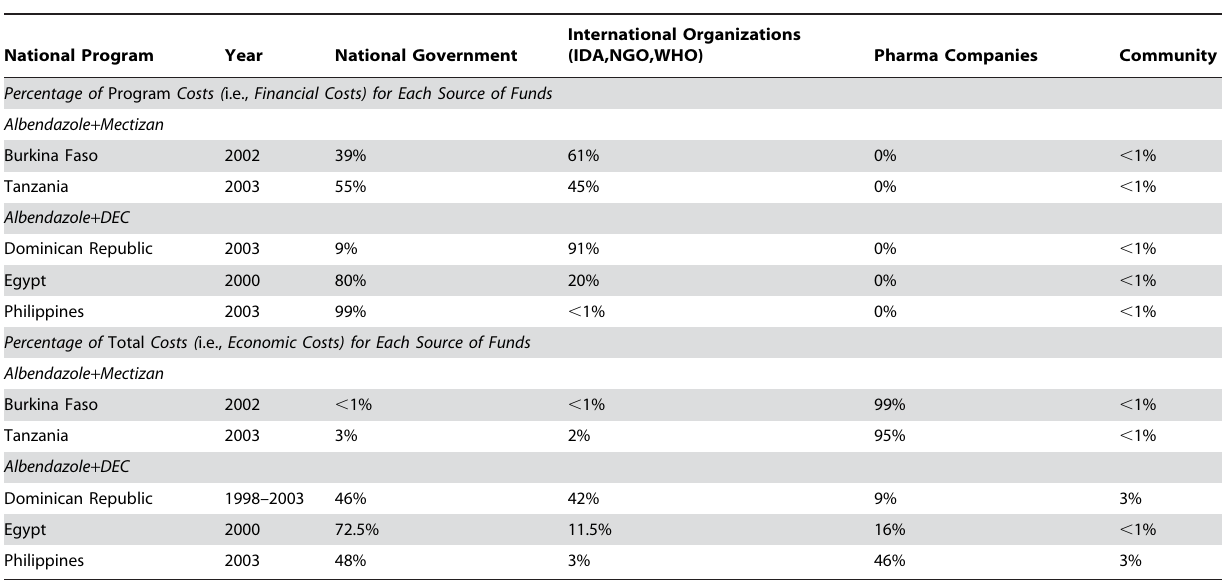
Table 7. Sources of Funding for LF Elimination